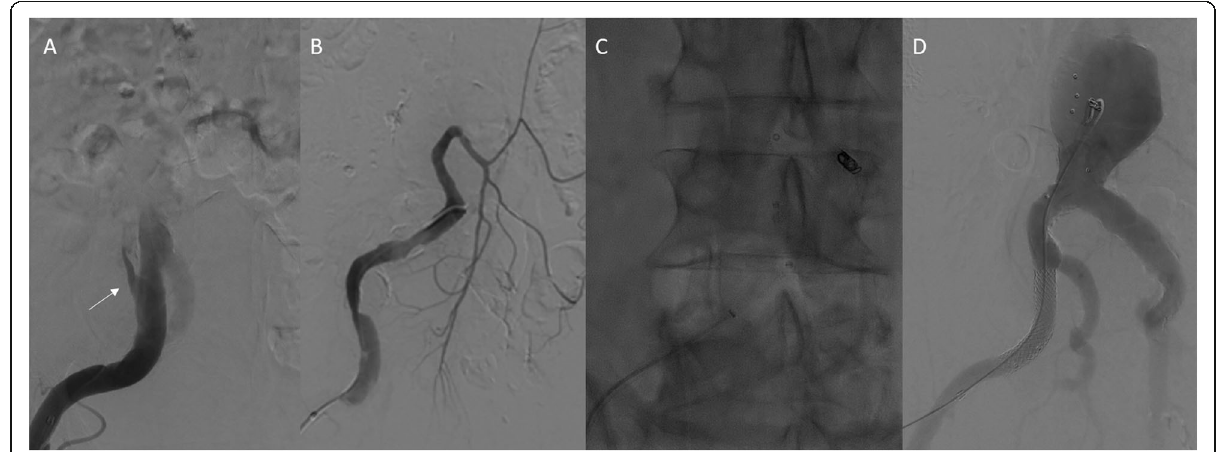
Fig. 3 Procedural angiography showing the filling right iliac artery through the iliac entry tear ( a ), the filling of the false lumen and the IMA ( b ), the position of the SMP plugs ( c ), and completion angiography showing filling of the true lumen with complete obliteration of the false lumen ( d